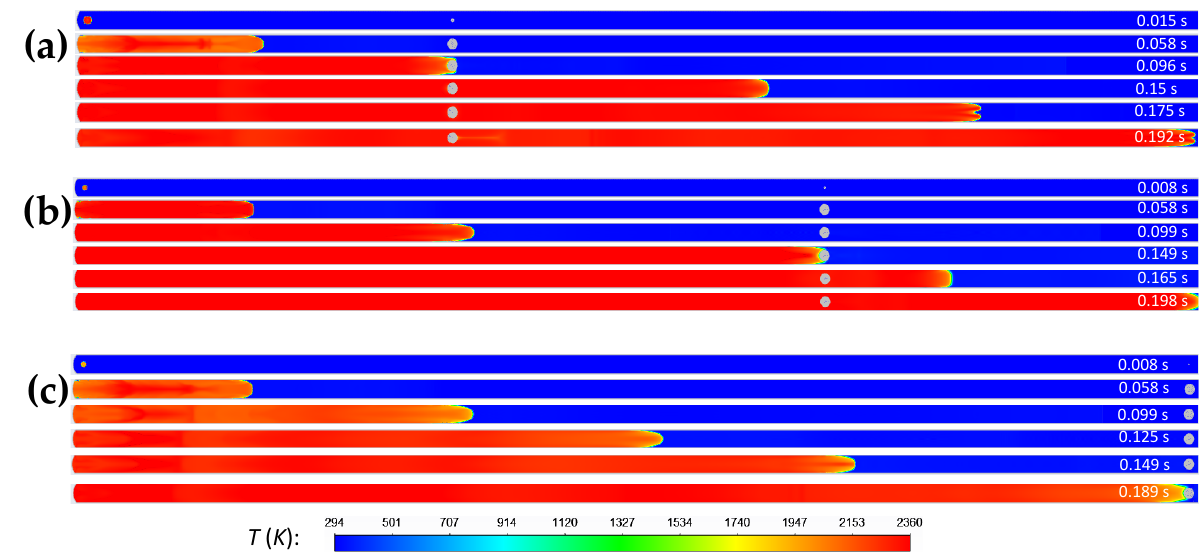
Figure 7. Flame propagation after explosion occurs for the scenarios in which a single obstruction is installed and inflated by 50% (half blocking the tube): ( a ) the obstruction is installed at x = 10 m; ( b ) the obstruction is installed at x = 20 m; and ( c ) the obstruction is installed at x = 30 m. Error! Reference source not found. shows the temperature profiles along the tube centreline at different times. As indicated above, the location where temperature abruptly drops indicates where the flame front is. Before the flame propagates out of the tube, com- pared to the empty tube, quite surprisingly, the flame propagates faster in tubes with a